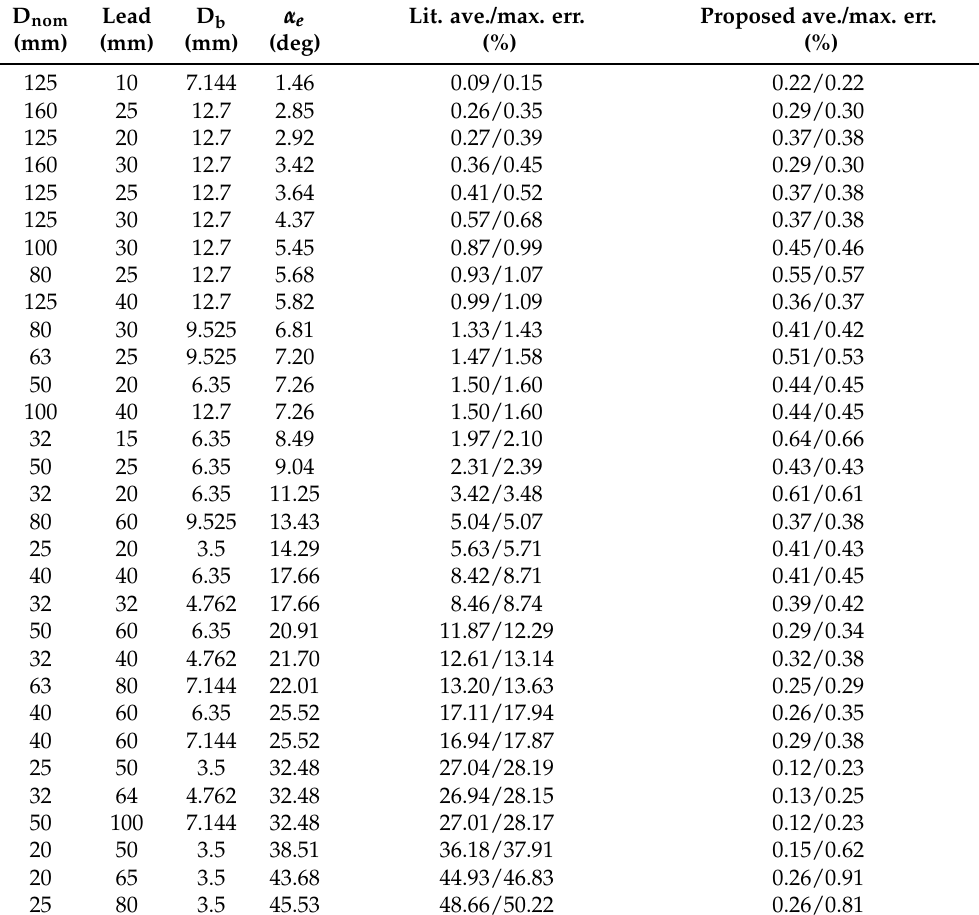
Table A2. Relative errors on the nut curvature committed by using the literature and proposed formulations for different off-the-shelf ball screws sizes, defined by the nominal diameter D nom , the lead and the spheres’ diameter D b . D nom Lead D b α e α e α e Lit. ave./max. err. Proposed ave./max.